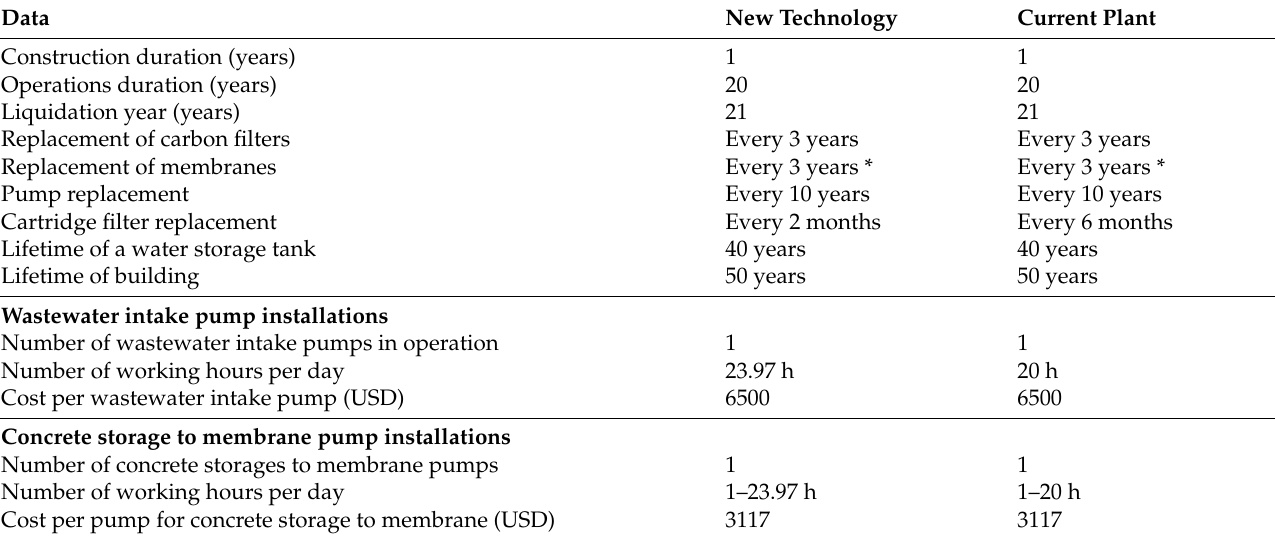
Table A1. Data used in this